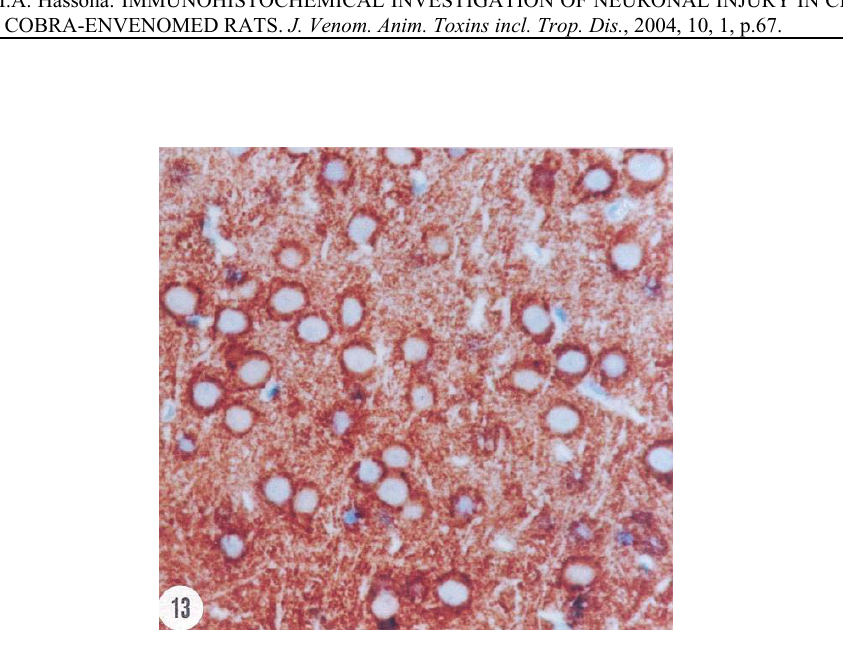
Figure 13. Accumulation of immunoreactive SYN expressed 48 hr after high dose envenoming. (X400)